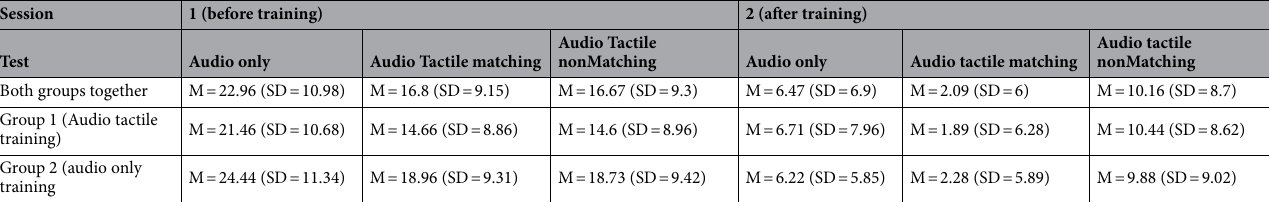
Table 2. SRT values in subsequent speech-understanding tests in both groups together and in each group separately. M mean, SD standard deviation.